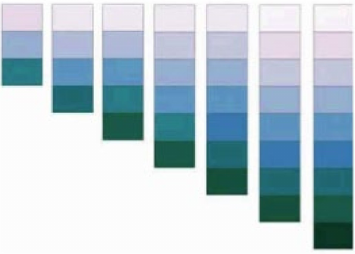
Figure 3. A multi-hued sequential scheme with 3–9 color classes